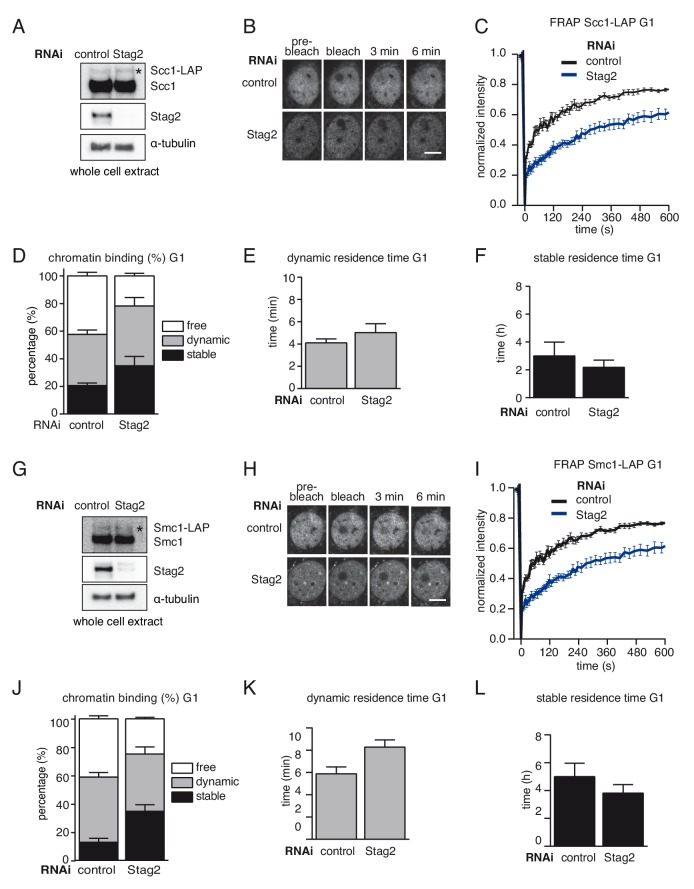
A subpopulation of cohesinSTAG1 associates stably with chromatin in quiescent MEFs.(A) Immunoblot analysis of whole cell extracts from control- and Stag2-depleted Scc1-LAP iMEFs cells synchronized in G0/1. Immunoblotting was performed using the indicated antibodies. The asterisk denotes the Scc1-LAP band. α-tubulin was used as a loading control. (B) Images of fluorescence recovery after photobleaching (FRAP) in Scc1-LAP cells synchronized in G0/G1 and depleted of Stag2 by RNAi. Scale bar, 10 µm. (C) Graph depicting the mean normalized fluorescence intensity after photobleaching in control- and Stag2-depleted Scc1-LAP cells synchronized in G1. Error bars denote s.e.m., n = 10 cells per condition. (D) Scc1-LAP distribution within the nucleus of control- and Stag2-depleted G0/G1 cells, as measured by FRAP. (E) Quantification of the dynamically chromatin bound residence time of Scc1-LAP in control- and Stag2-depleted cells synchronized in G1. (F) Quantification of the stably chromatin bound residence time of Scc1-LAP in control- and Stag2-depleted cells synchronized in G1. (G) Immunoblot analysis of whole cell extracts from control- and Stag2-depleted Smc1-LAP iMEFs cells synchronized in G0/1. Immunoblotting was performed using the indicated antibodies. The asterisk denotes the Smc1-LAP band. α-tubulin was used as a loading control. (H) Images of fluorescence recovery after photobleaching (FRAP) in Smc1-LAP cells synchronized in G0/G1 and depleted of Stag2 by RNAi. Scale bar, 10 µm. (I) Graph depicting the mean normalized fluorescence intensity after photobleaching in control- and Stag2-depleted Smc1-LAP cells synchronized in G1. Error bars denote s.e.m., n = 10 cells per condition. (J) Smc1-LAP distribution within the nucleus of control- and Stag2-depleted G0/G1 cells, as measured by FRAP. (K) Quantification of the dynamically chromatin bound residence time of Smc1-LAP in control- and Stag2-depleted cells synchronized in G1. (L) Quantification of the stably chromatin bound residence time of Smc1-LAP in control- and Stag2-depleted cells synchronized in G1.Figure 2—figure supplement 3—source data 1.The Microsoft Excel file lists FRAP measurements used to generate data in Figure 2—figure supplement 3C–F.Figure 2—figure supplement 3—source data 2.The Microsoft Excel file lists FRAP measurements used to generate data in Figure 2—figure supplement 3H–L.